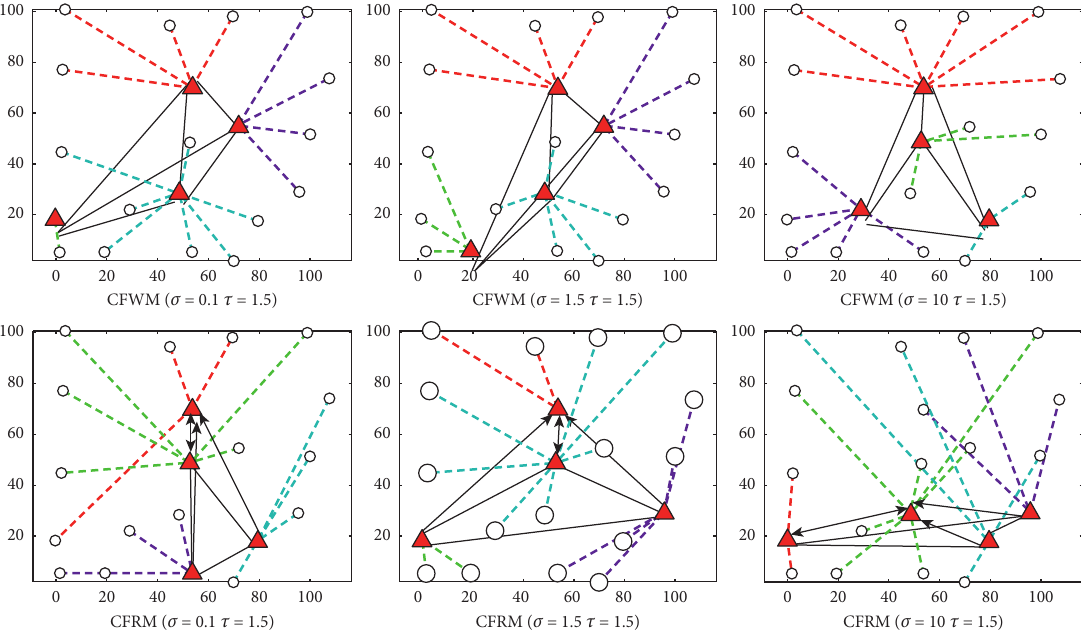
Figure 6: Influence of parameter σ on network design.